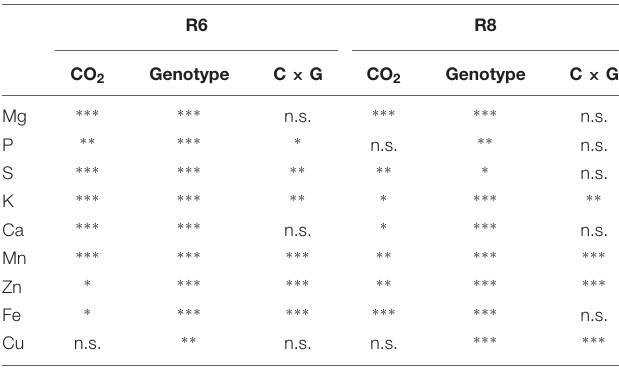
TABLE 3 | Significance levels of main effects and interactions of CO 2 and cultivars on soybean grain element nutrients concentrations at R6 and R8. R6 R8